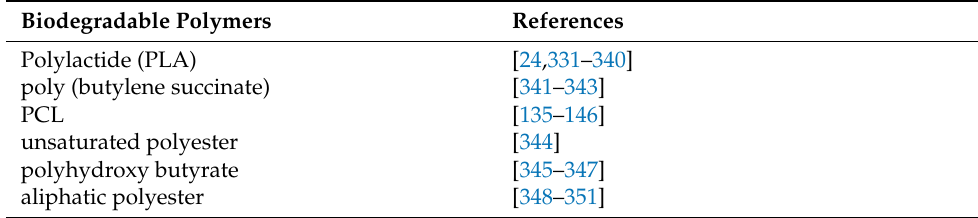
Table 6. Biodegradable polymers. Biodegradable